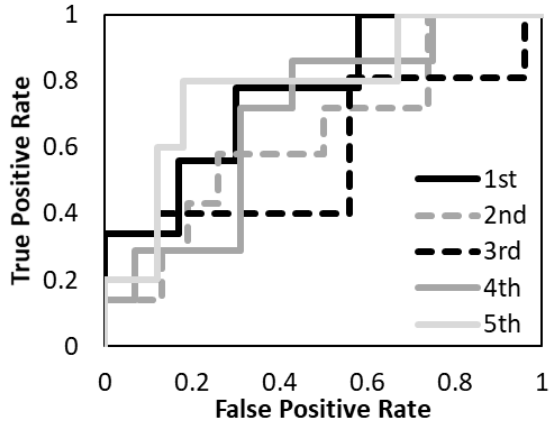
Figure 6. The performance of the predictive model with the T2-weighted MR image was evaluated according to the ROC metrics.